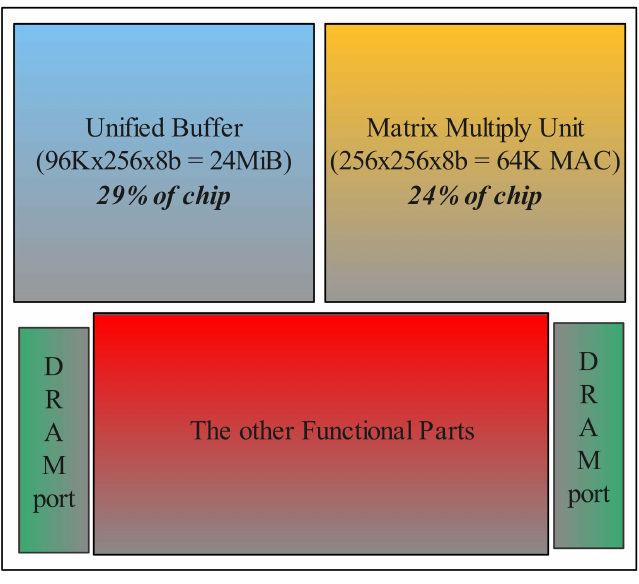
Figure 1. The structure of